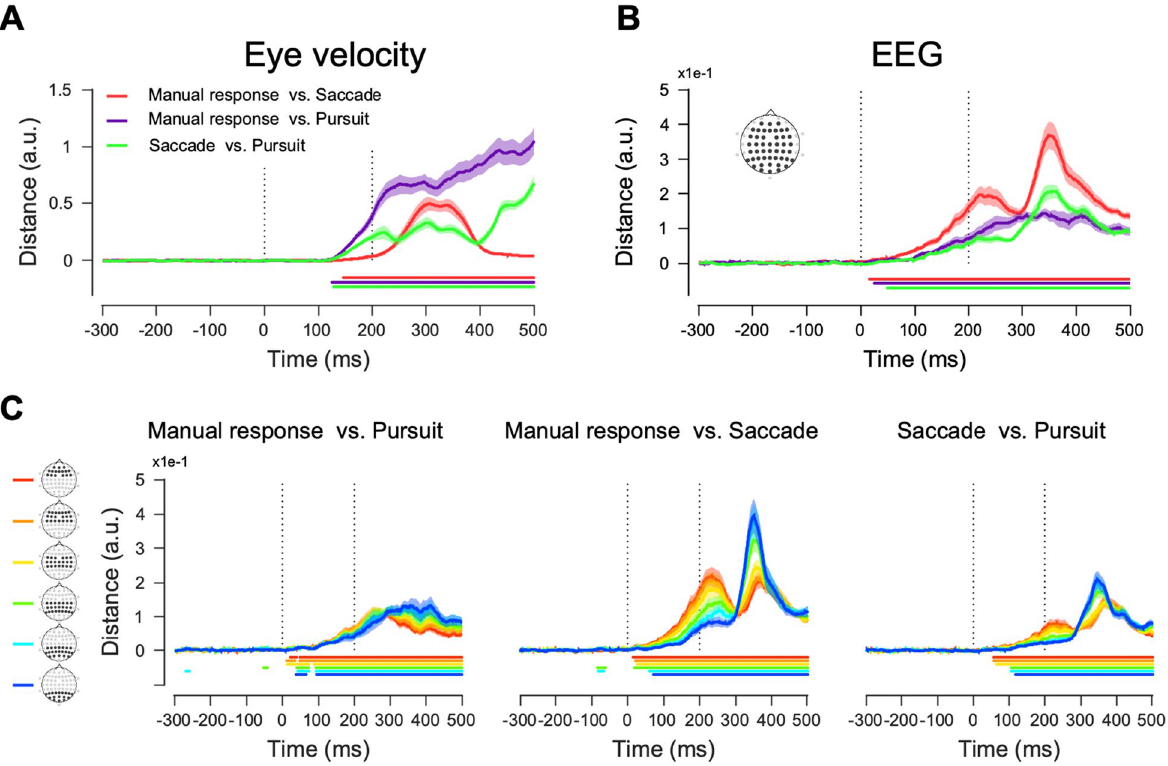
Figure 3. Mahalanobis distances between eye velocities and multivariate EEG activity patterns comparing different effector behavior conditions when a given stimulus’s motion direction is the same. ( A ) Eye velocity dissimilarities showing pairwise comparisons among motor effector conditions using manual response, saccade, and pursuit. ( B ) EEG dissimilarities showing pairwise comparisons among the three motor effector conditions. The recorded data from 47 electrodes were used for calculating the Mahalanobis distances. ( C ) EEG dissimilarities were estimated from six subsets of channels. Means and standard errors across participants were plotted as colored solid lines and shaded areas, respectively. Vertical dotted lines indicate the motion period, and color lines under the plot show the time points where the distances are significantly different from the baseline (two-sided cluster-based permutation test, p <